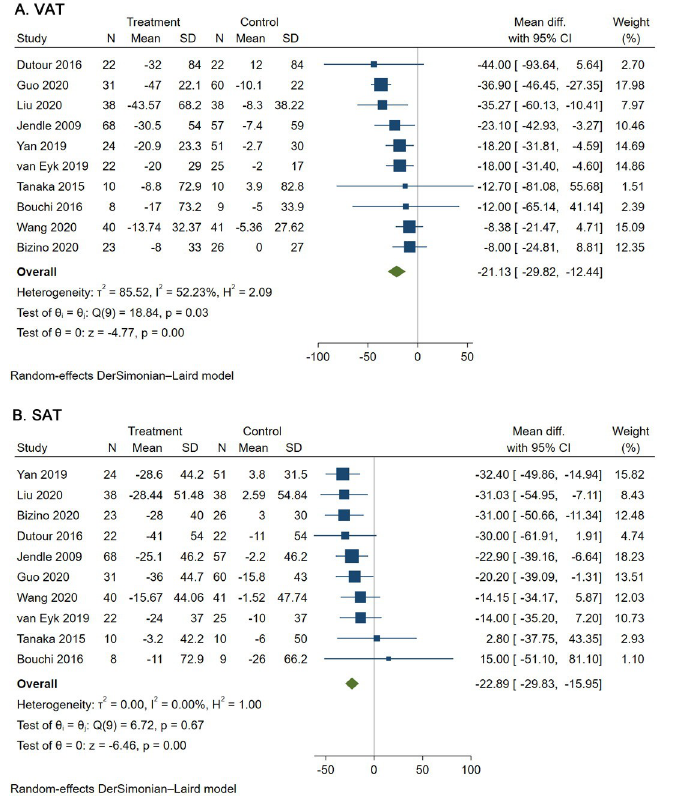
Fig 2. Random-effects pooled MD for VAT and